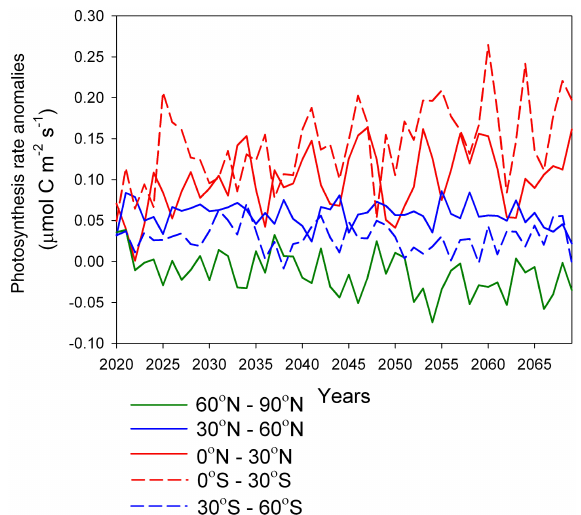
Figure 3. Regional-averaged annual photosynthesis rate difference of G4SSA minus RCP6.0 from 2020 to 2069 when sulfate injection geoengineering was